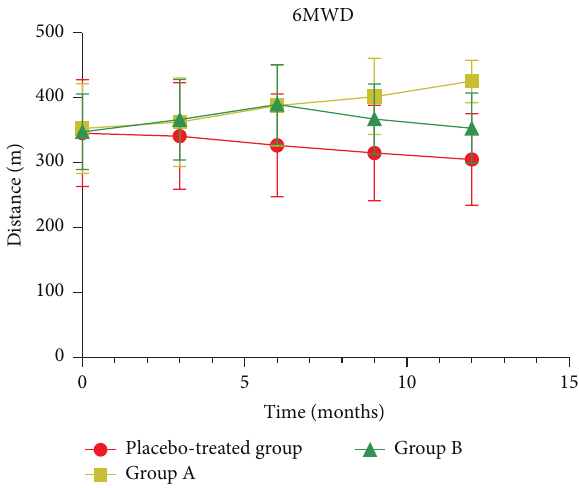
Figure 4: The effect of erythromycin on six-minute walk distance (6MWD, m) in chronic obstructive pulmonary disease patients at baseline and after 3, 6, 9, and 12 months of treatment. Erythromycin did significantly improve the 6MWD after 6, 9, and 12 months of treatment in group A (all 𝑃 values < .05) and after 6 months of treatment in group B ( 𝑃 = .038 ) compared to the placebo-treated